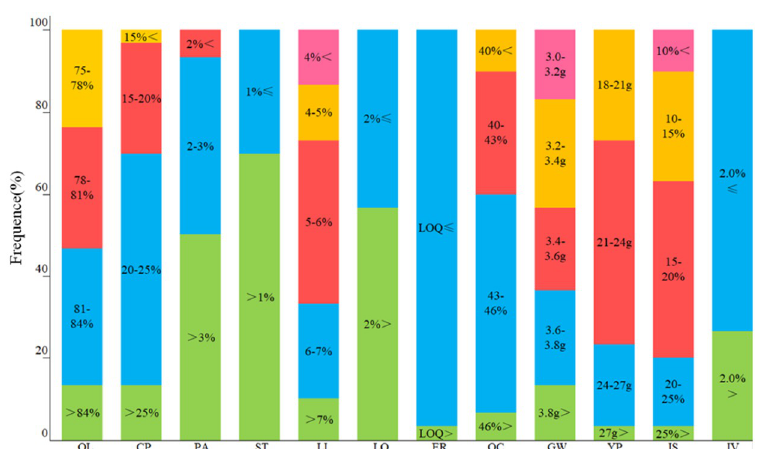
Fig 1. Variation distribution of qualitative traits of high-oleic rape germplasms. OL: Oleic, CP: Crude protein, PA: Palmitic acid, ST: Stearic acid, LI: Linoleic acid, LO: Linolenic acid, ER: Erucic acid, OC: Oil content, GW: 1000-grain weight, YP: Yield per plant, IS: Incidence rate of Sclerotinia clerotiorum , IV: Incidence rate of viral diseases. The percentages of oleic acid, palmitic acid, stearic acid, linoleic acid, linolenic acid and erucic acid are the percentages of total fatty acids. The percentages of oil content and crude protein were obtained as their percentages in whole seed. The percentages of Sclerotinia sclerotiorum and viral diseases were obtained as their incidence rate in these plant materials. The same as below. LOQ: Erucic acid standard of "double low" rapeseed oil, 3%.